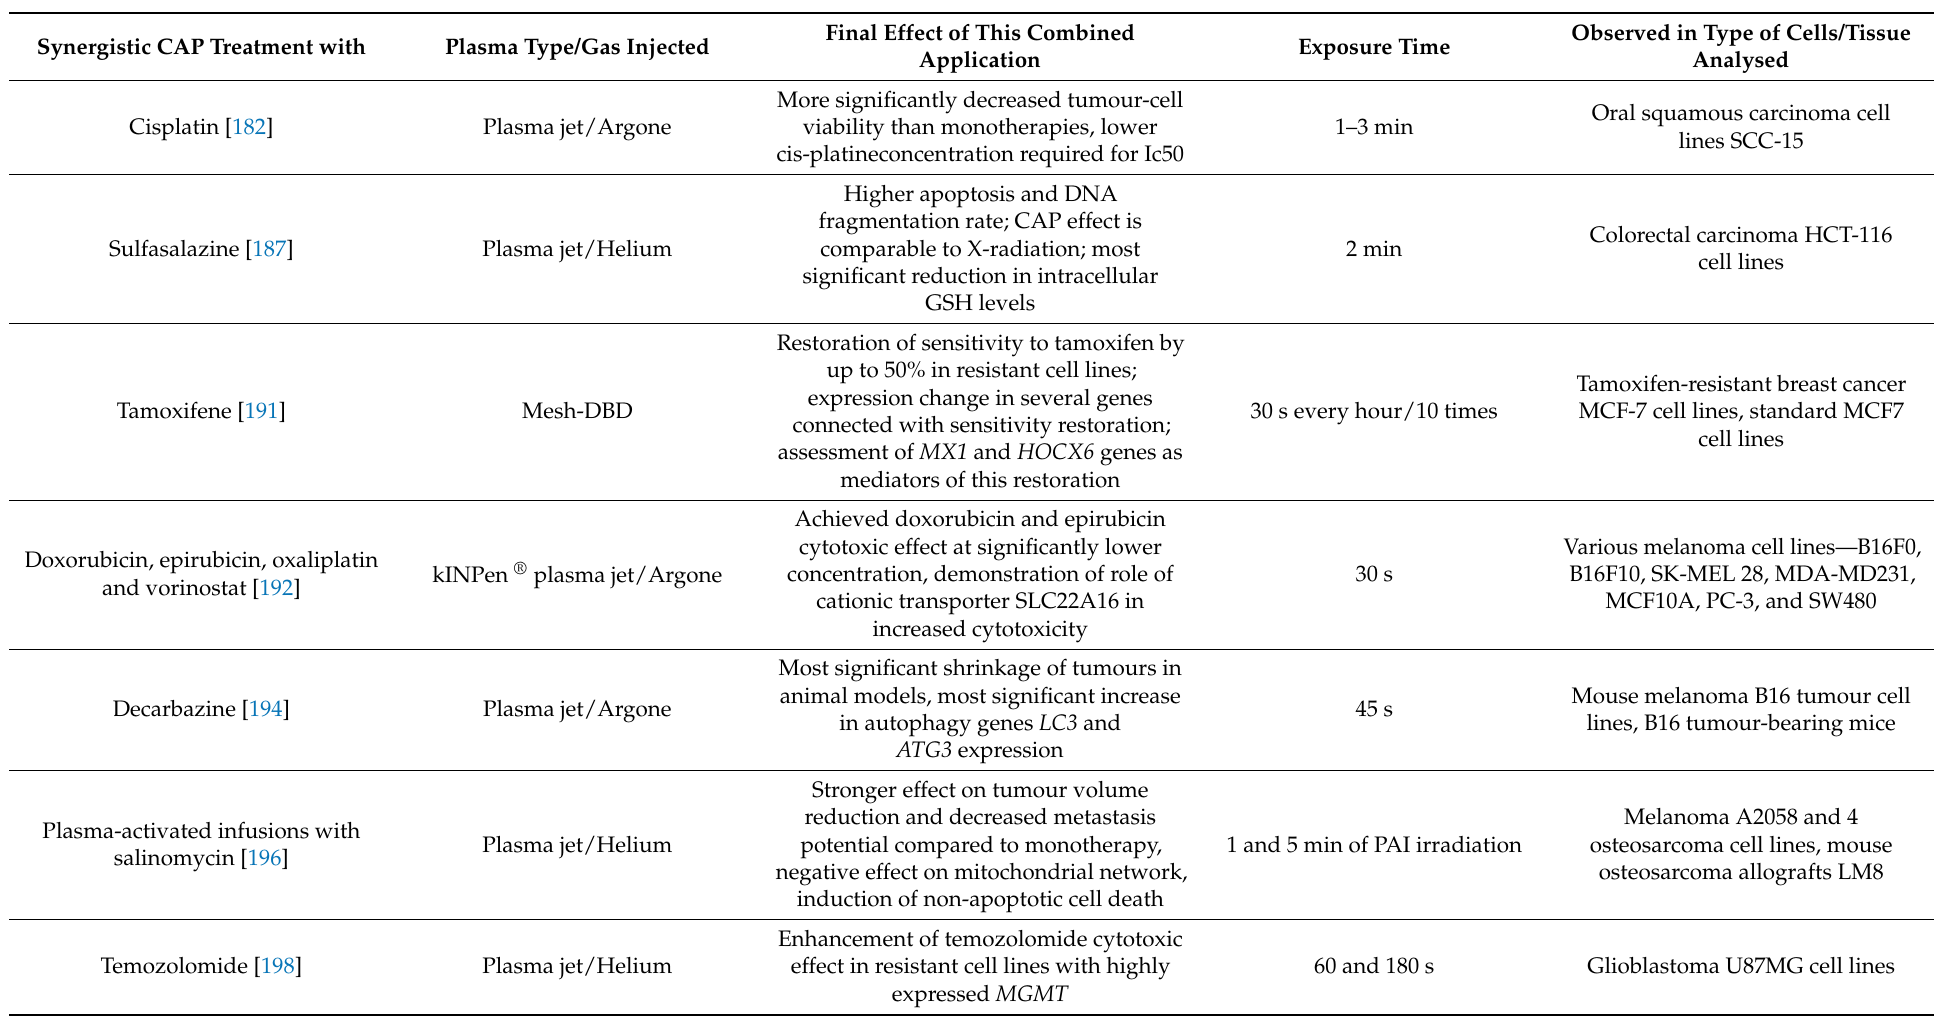
Table 2. List of synergistically applied CAP with routine pharmaceuticals, chemotherapeutic agents, and